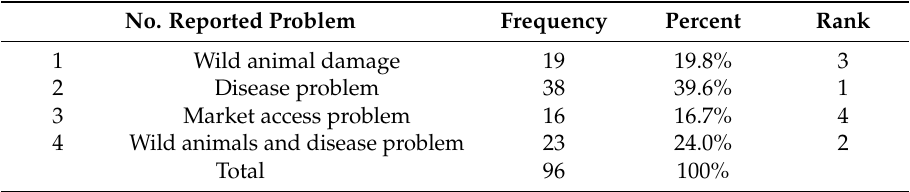
Table 3. Reported problems for low fruit and vegetable income with user groups.